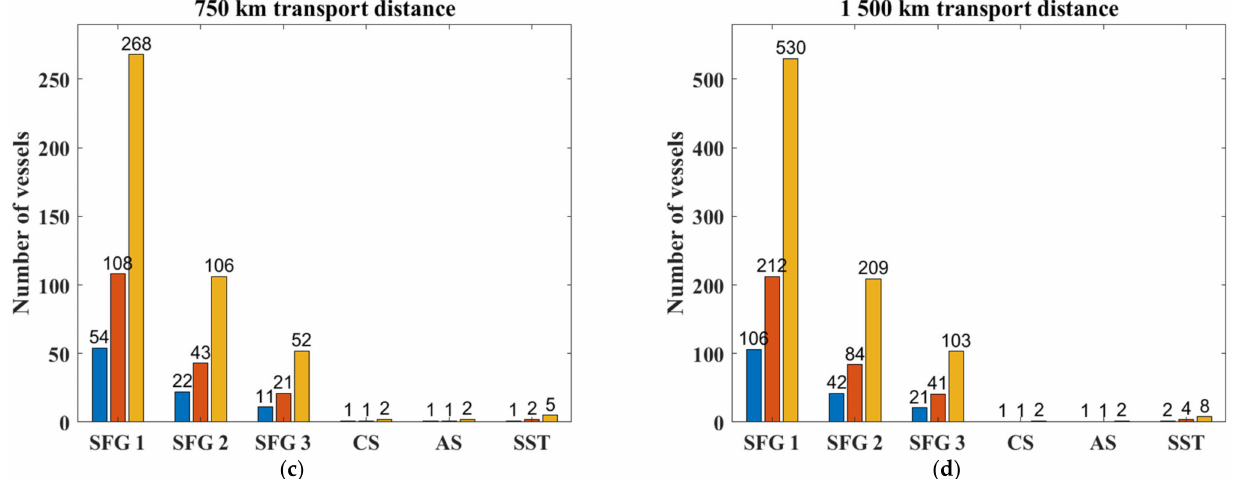
Figure 7. Minimum number of vessels required to fulfil the mission: ( a ) 180 km; ( b ) 500 km; ( c ) 750 km; ( d ) 1500 km. Abbreviations: SFG1: subsea freight glider (469 m 3 ); SFG2: subsea freight glider (1194 m 3 ); SFG3: subsea freight glider (2430 m 3 ); CS: crew ship (22,000 m 3 ); AS: autonomous ship (22,000 m 3 ); SST: subsea shuttle tanker (10,569 m 3 ).